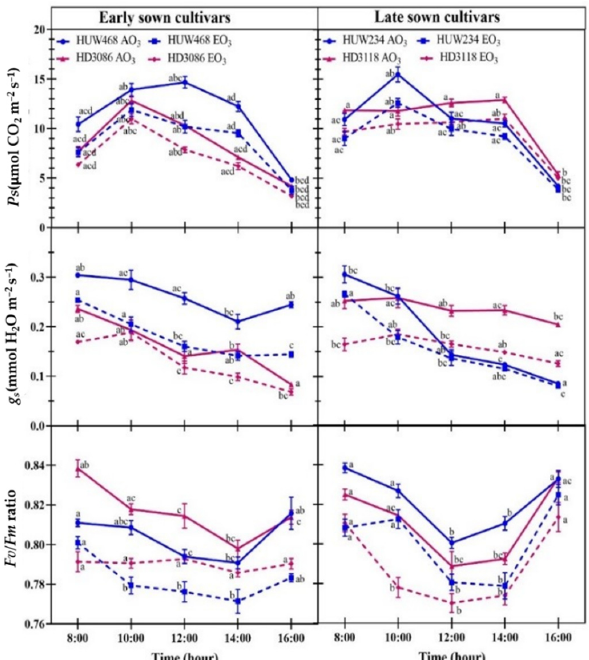
Figure 2. Diurnal variations in photosynthetic rate ( Ps ), stomatal conductance ( g s ), and chlorophyll fluorescence ( Fv/Fm ) of flag leaves in early (HUW468 and HD3118) and late sown (HUW234 and HD3118) wheat cultivars under ambient and elevated O 3 treatments. The letters on top of the line graph are based on the Tukey test among the 5 different time intervals of a day. Lines without the same letter are significantly different from each other at p < 0.05. Values are mean ± SE; N = 5 replicate leaves of 5 plants for each treatment. Solid lines represent plant response under ambient O 3 condition and dotted lines indicate plant response under elevated O 3 condition. Different color in a box represents different cultivar.